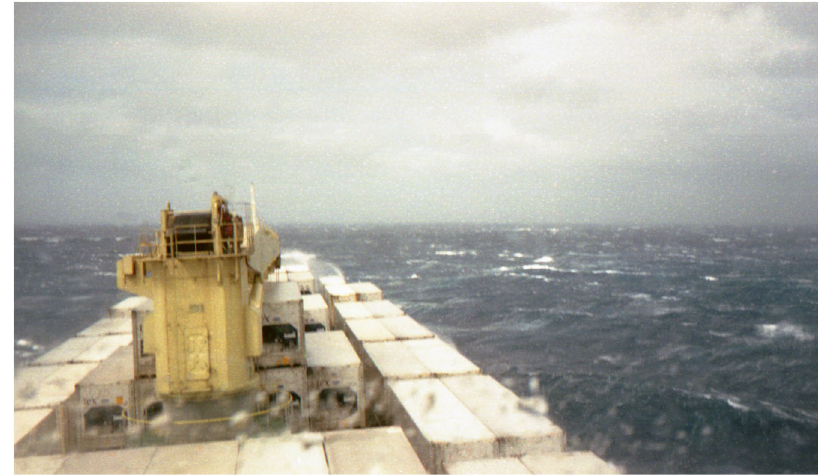
Fig. 3 Waves on Cargo. Photograph was taken by a participant of waves coming near